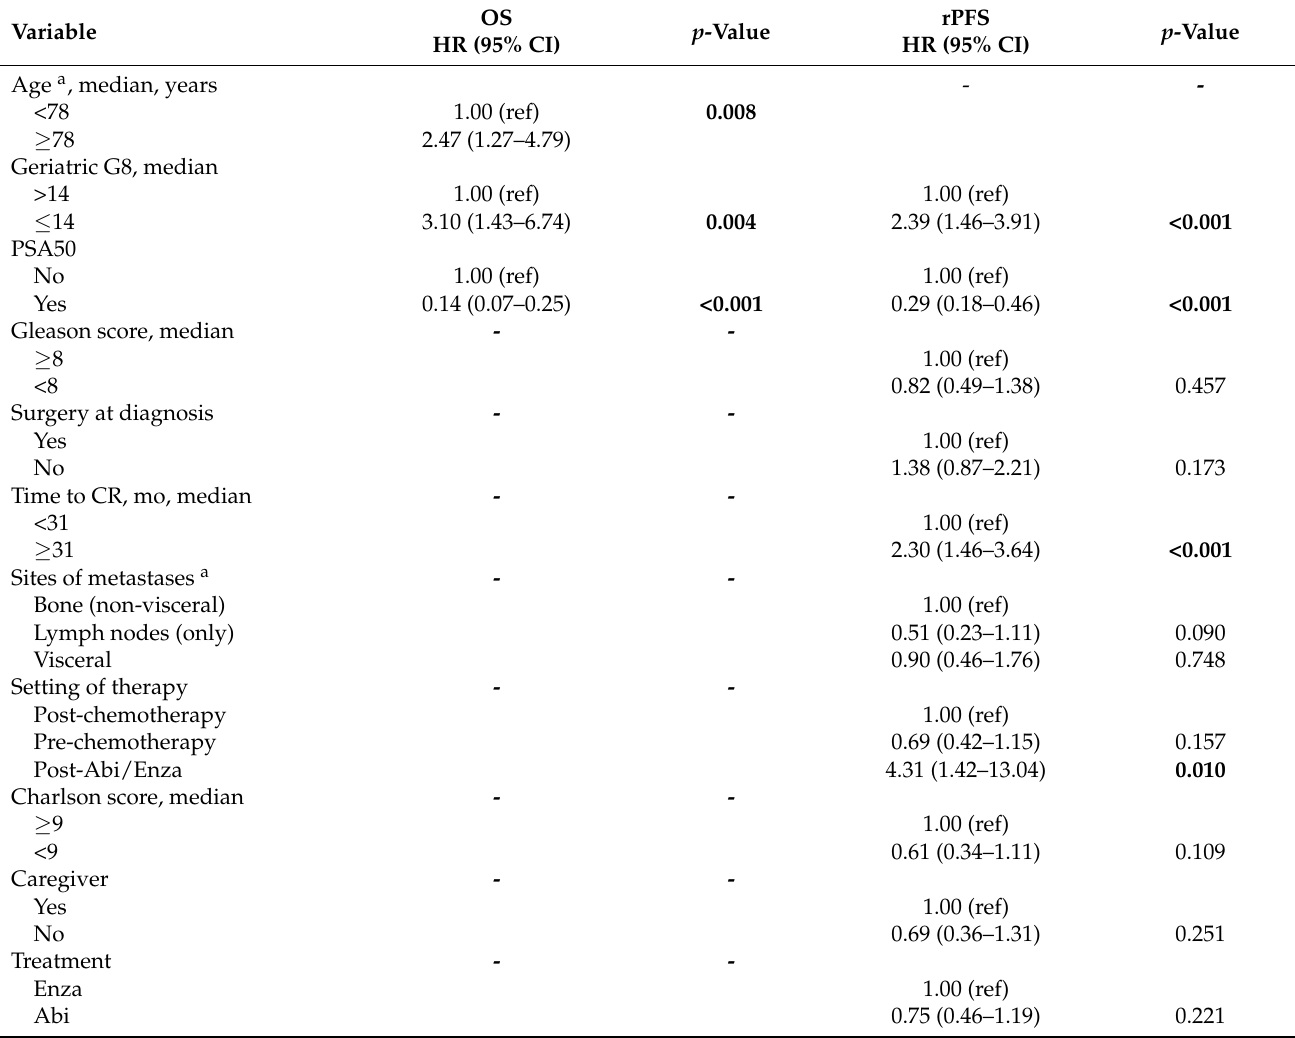
Table 2. Cox regression multivariable analysis of clinical baseline and on-treatment prognos- tic